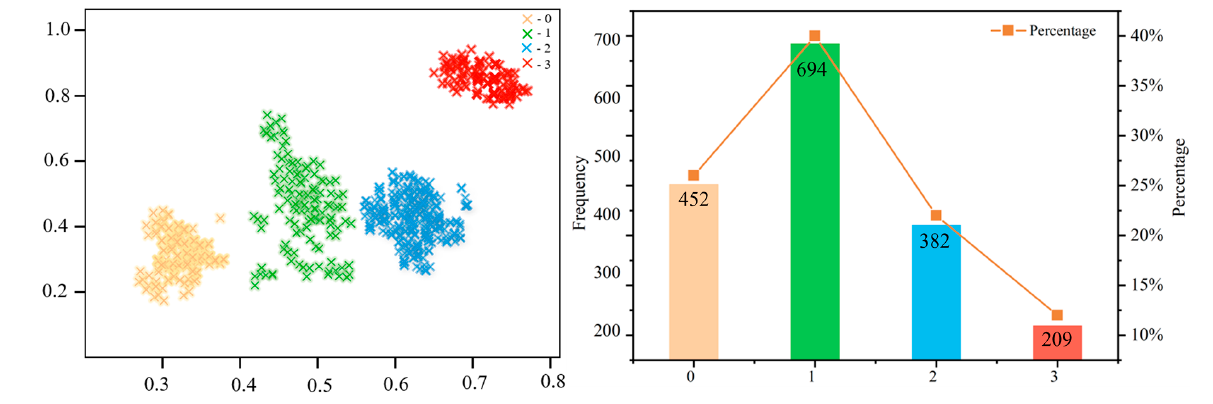
Figure 4. SOM clustering